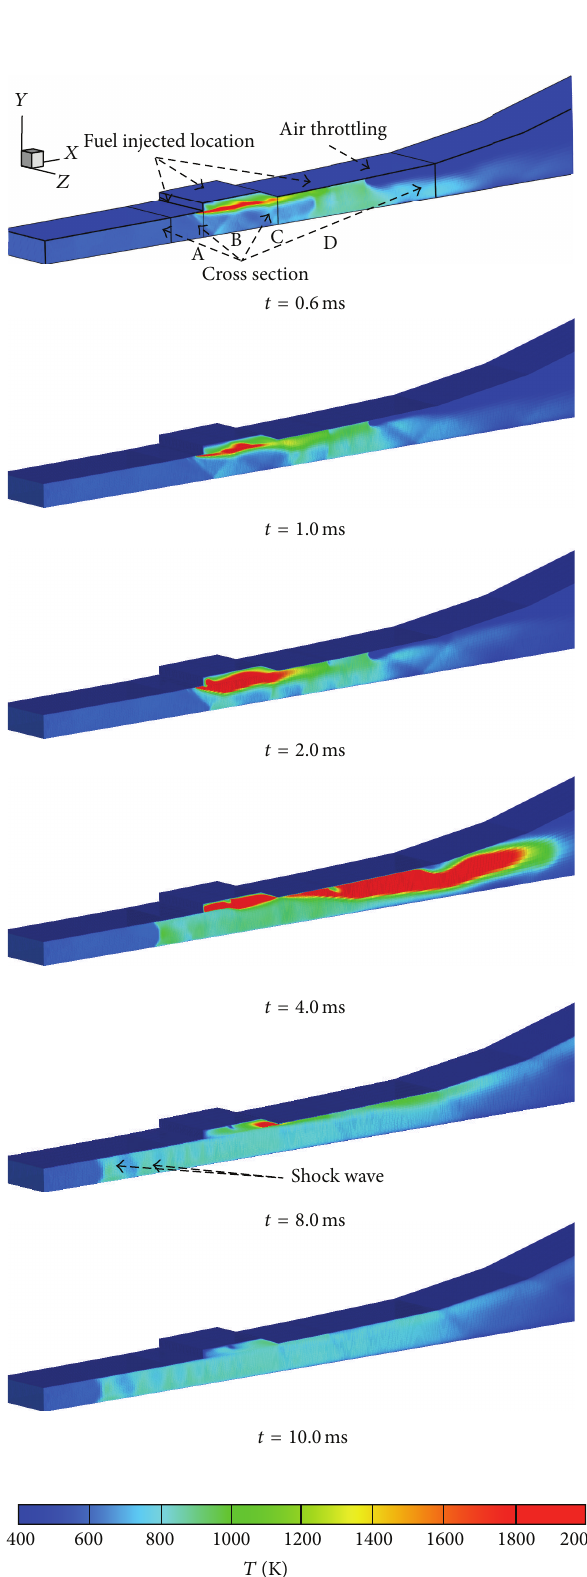
Figure 9: Evolution of the temperature field in the scramjet combustor during the ignition transient without air